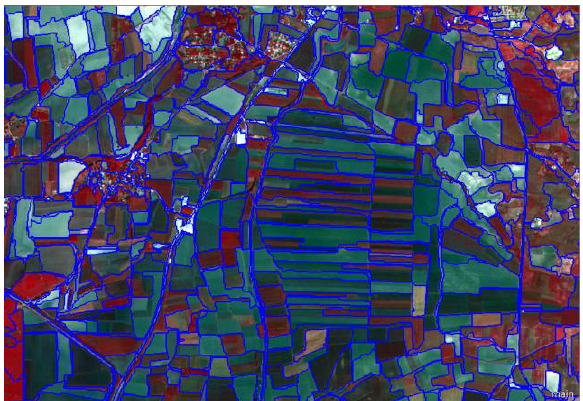
Figure 3.Segments at the segmentation stage of object-based classification